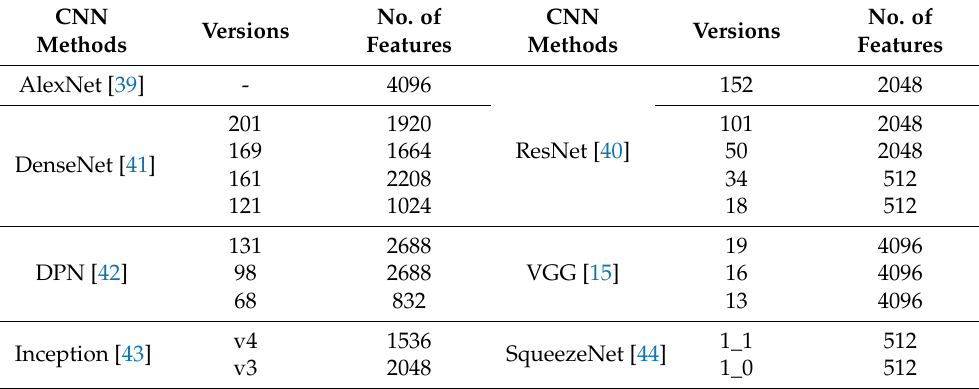
Table 1. Various feature vectors for the state-of-the-art CNN methods employed for benchmarking our novel